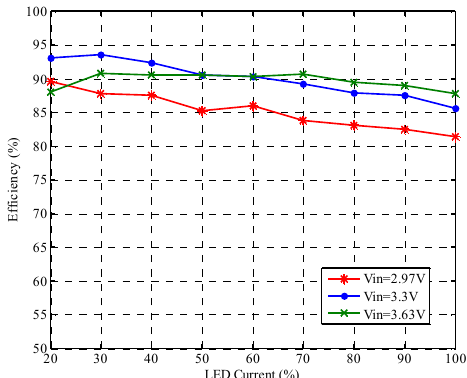
Figure 24. Measured efficiency versus LED current [15].